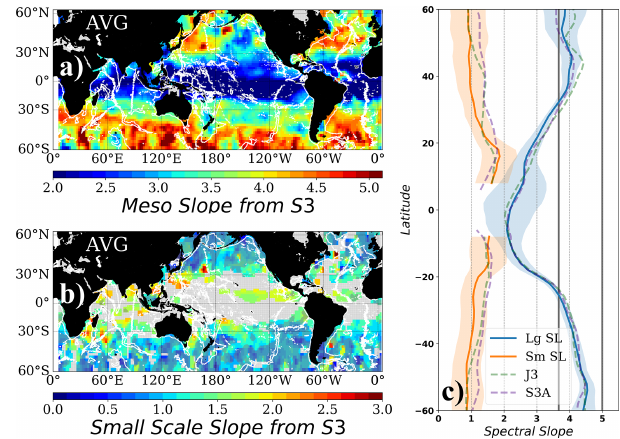
Figure A2. (a) Mesoscale and (b) small-scale spectral slopes fitted to the observed unbiased PSD from Sentinel-3A. The noise func- tion used to unbias the full PSD corresponds to a red-type noise function. (c) Zonal average of the mesoscale and small-scale spec- tral slopes in (a) and (b) . Vertical gray lines denote the k − 11 / 3 and k − 5 spectral slope values. Gray shading in (b) corresponds to zones where the uncertainty associated with the slope estimate is higher than 40% of the slope value. Blank areas in (b) correspond to zones where the double-slope model does not describe the observed shape of the spectrum. Dashed green and purple lines in (c) correspond to Jason-3 and Sentinel-3A zonal averages from Figs. 4c and 5c, respectively. White contours represent the topography at 3000m